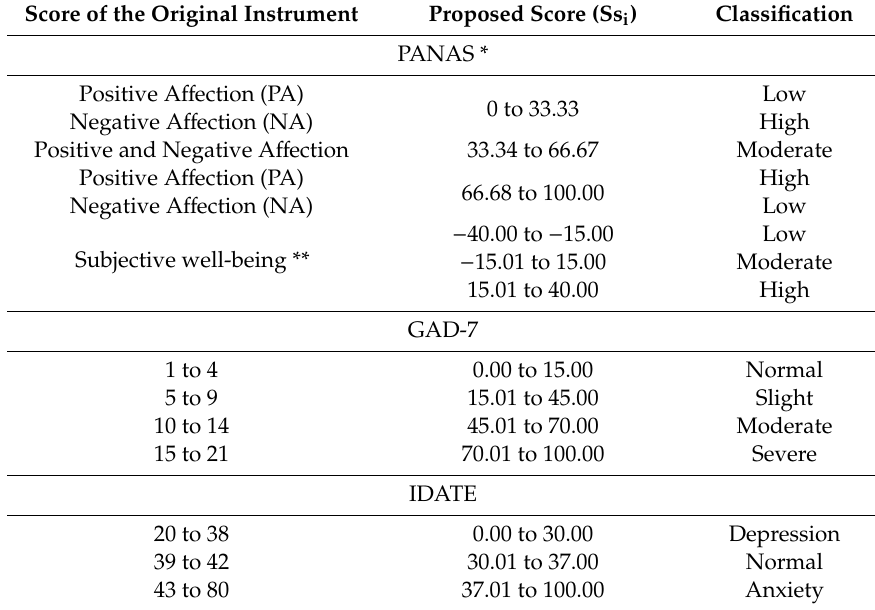
Table1. Adaptationofscoresoriginallyproposedbytheauthorsofthesescales,withthestandardizedscore. Score of the Original